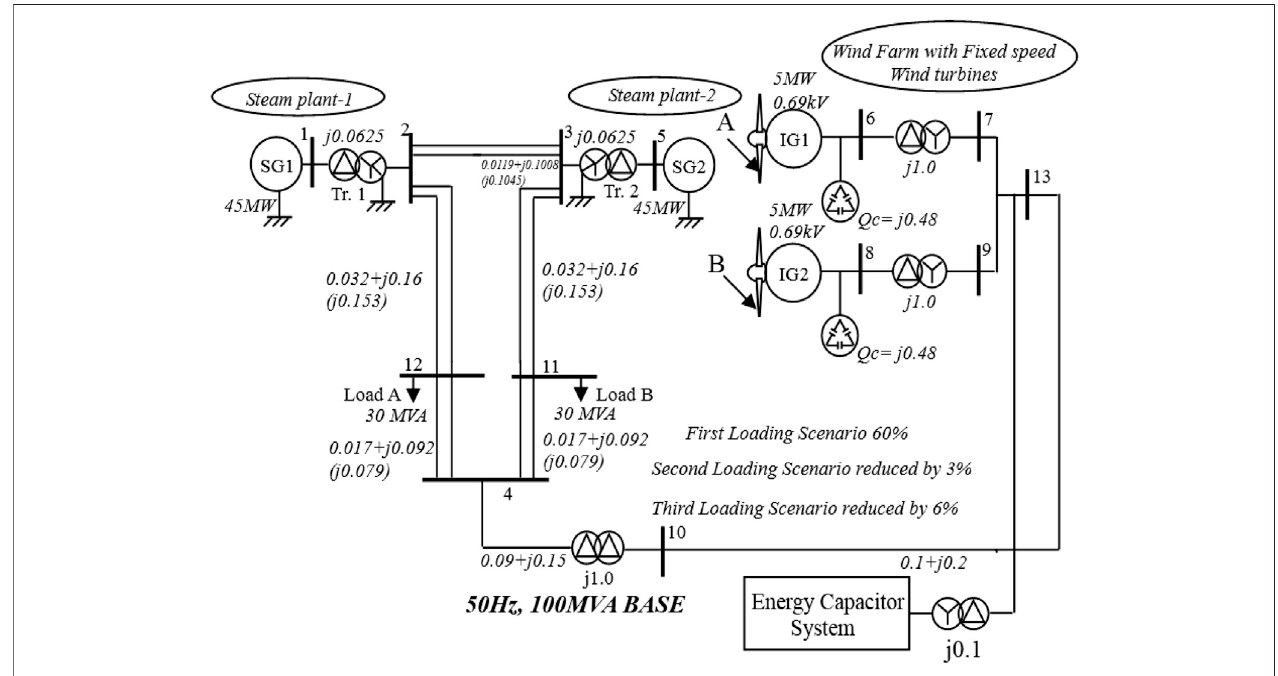
FIGURE 1 | Model system of study.